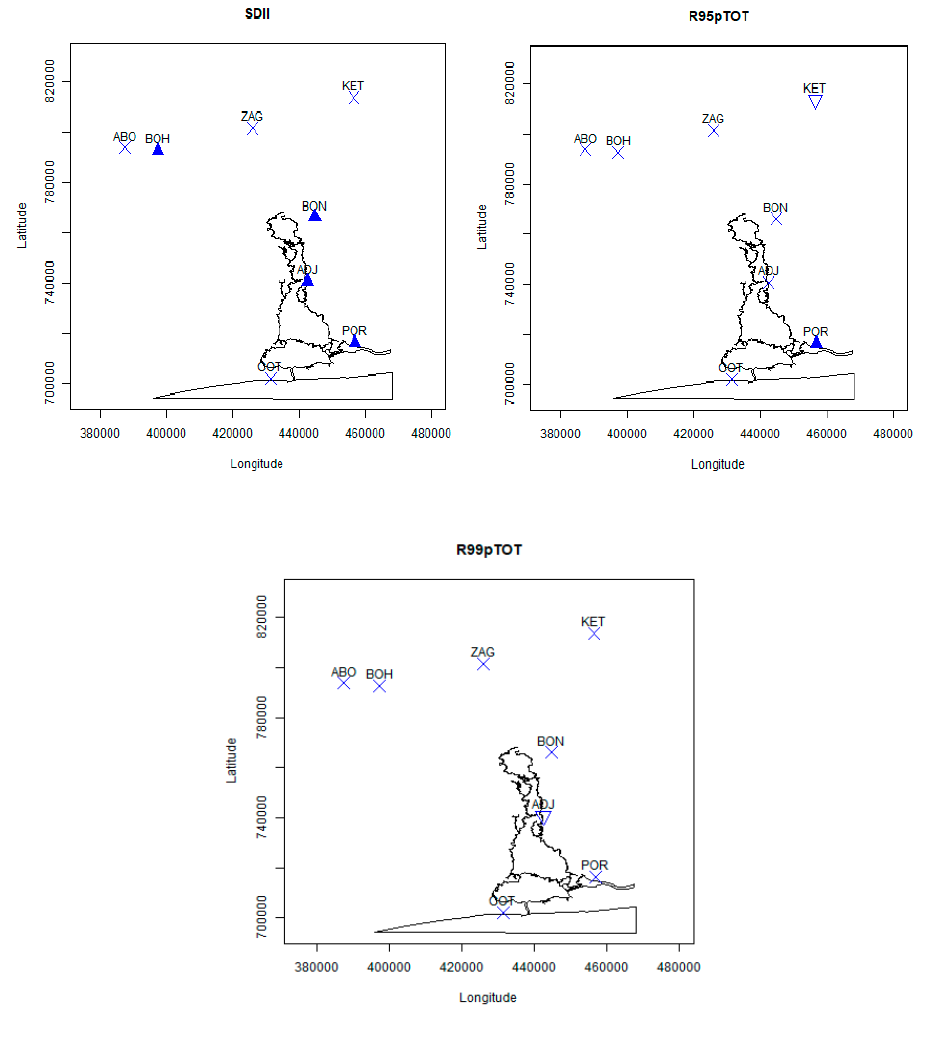
Figure 4. Plot of Simple daily intensity index (SDII), very wet day (R95pTOT), and extremely wet days (R99pTOT) trend over Ouémé Delta.